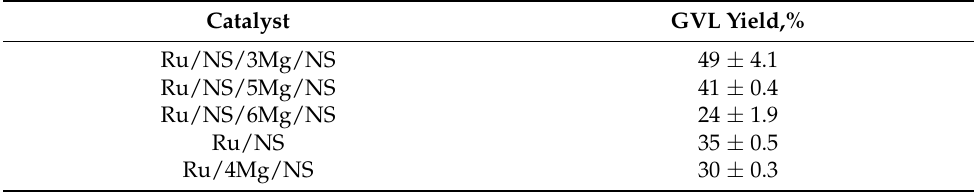
Table 4. Activity of the catalysts in hydrogenation of levulinic acid. Reaction conditions: 20 mL